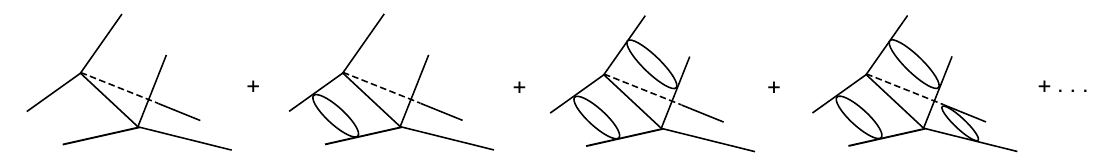
Figure 6. The (cid:12)rst set of diagrams (\contact" diagrams) contributing to the six-point function at order 1 =N 2